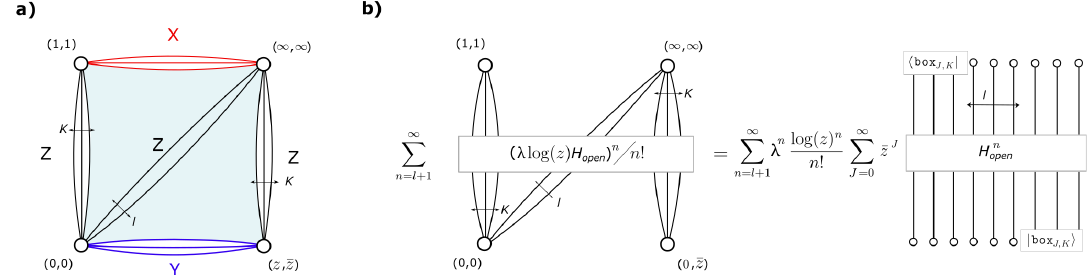
Figure 6 . a) Asymptotic octagon with l bridges O l ( z, ¯ z ) , in light-blue. Solid lines are propagators at the tree level in the corresponding asymptotic correlator. b) Relation between the octagon in light-cone kinematics and the sl (2)